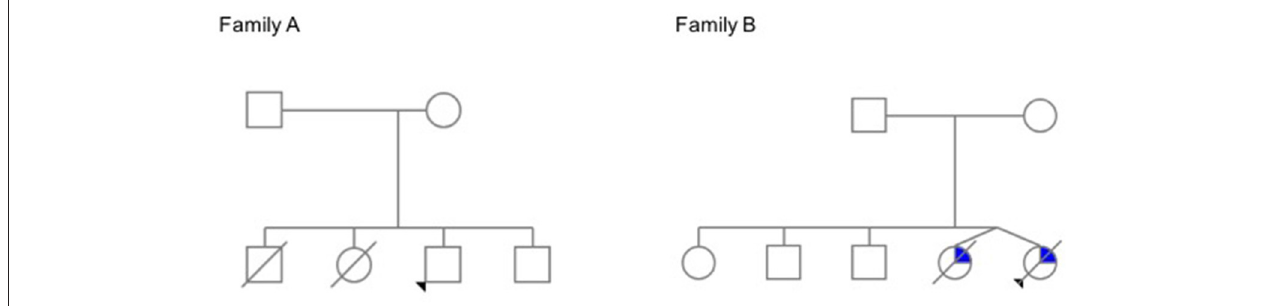
FIGURE 2 | Family trees. In Family A , the elder siblings of the proband died young of lymphoma. The proband has a history of avascular necrosis of the femoral head, short stature and isolated CD4 + deficiency; his younger brother is asymptomatic. In Family B , teenage twin sisters died after a long history of recurrent infections, chronic liver disease, and progressive bone marrow failure (The pedigrees were built at pedigree.progenygenetics.com; they are included after written informed consent from the